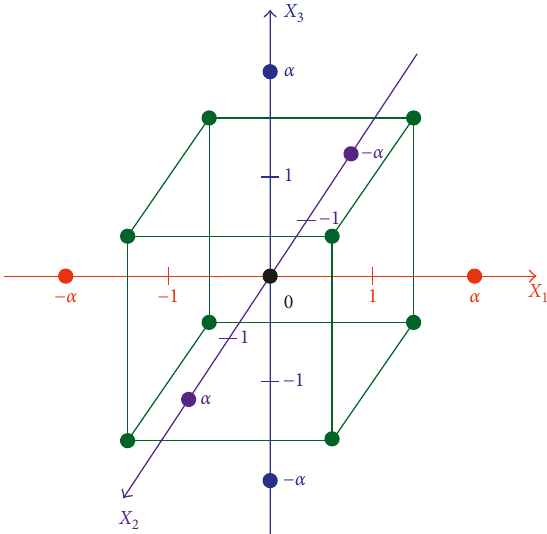
Figure 1: Graphical representation of the rotatable design for the three